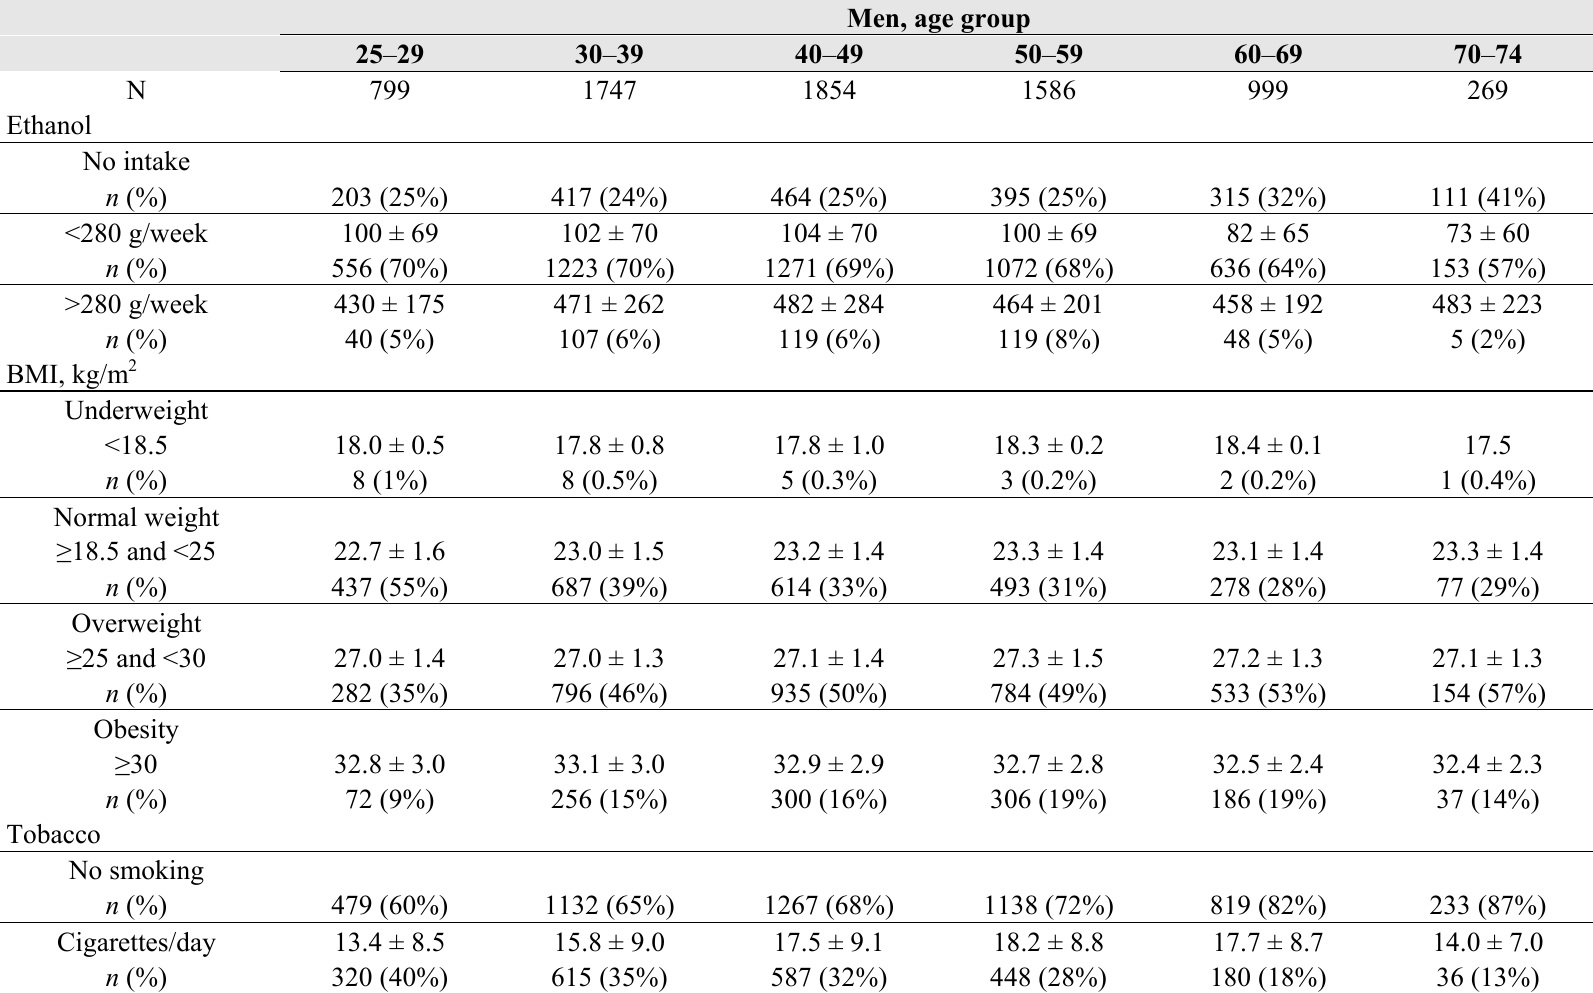
Table 1. Main characteristics of the study population as classified according age, gender, ethanol consumption, BMI and